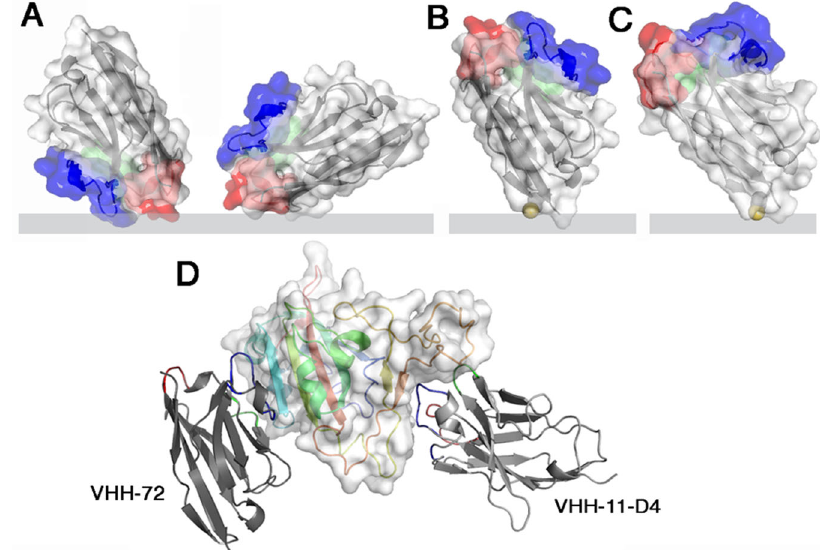
Fig. 1 Different generations of nanobodies were used in this work and integrated into the electrochemical sensing device. Surface and ribbon views of the VHHs (the three CDRs are colored red, green, blue, respectively): A VHH-72 can bind the sensor in different orientations. B VHH-72-C13 is oriented on the sensor by the Cys link (yellow). The direct linkage to the gold electrode is shown rather than the thiol-PEG-MAL linker, considered more meaningful. C VHH11-D4-C13 is oriented on the sensor surface by the Cys link (yellow). D Ribbon views of the two VHHs bound to the Spike RBD (rainbow colored, white surface). Note the large distance between the two epitopes. VHHs af fi nity constants determined by BLI: VHH-72 (K D = 36.6 nM), VHH-72-13C (K D = 12.1 nM), VHH-H11D4-13C (K D = 5